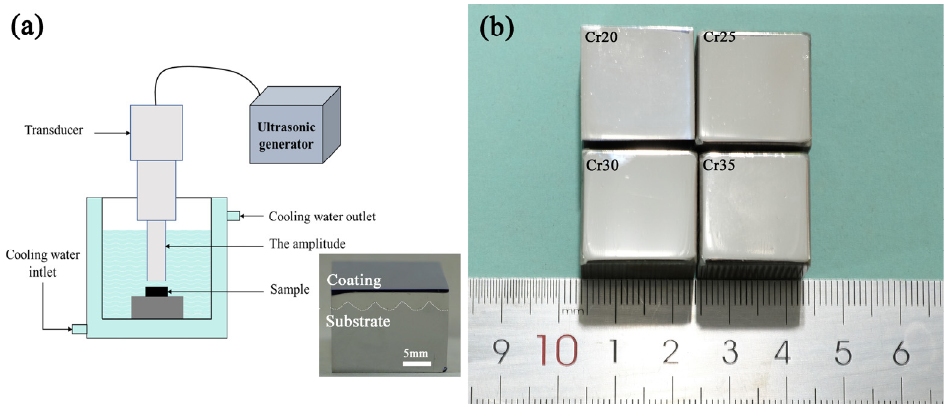
Figure 5. Schematic diagram of ultrasonic cavitation tests equipment ( a ) and macrosurface morphol- ogy of coatings ( b ).